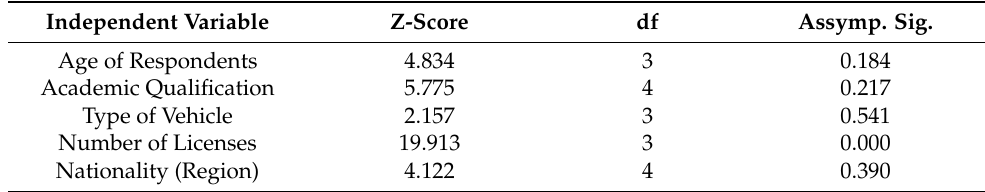
Table 5. Kruskal Wallis H test results.